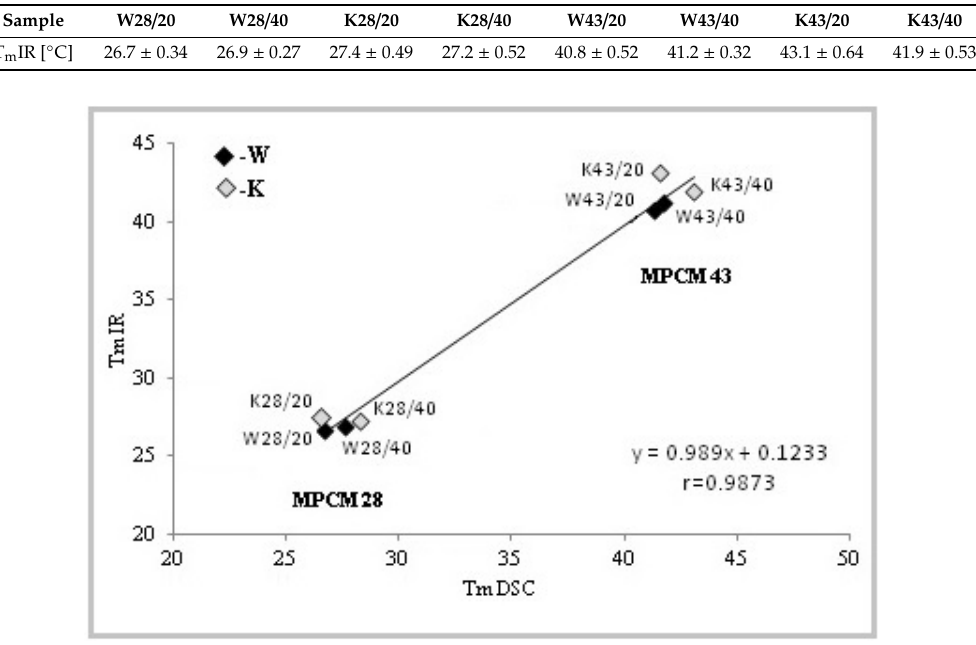
Figure 7. Comparison of MPCM melting temperatures determined by DSC and infrared thermography for woven (W) and knitted fabrics (K) modified with paste P/20 and P/40.